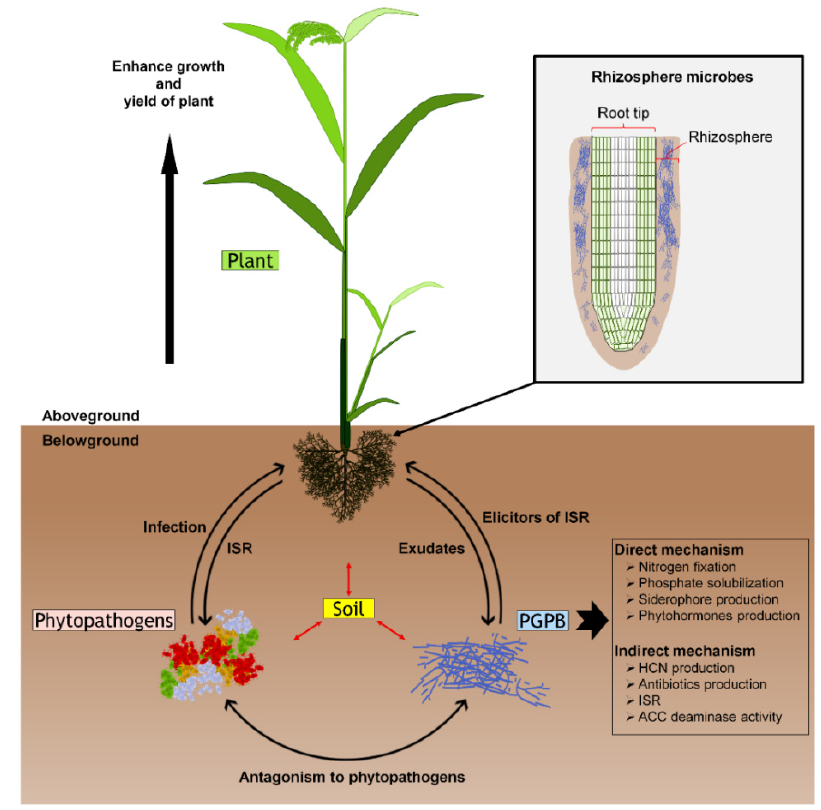
Figure 1. Biological control interactions exerted by the plant growth-promoting bacteria (PGPB). This illustration depicts the interactions between PGPB, phytopathogens, and plants. PGPB promote plant growth either by direct and or indirect mechanisms. PGPB colonize plant’s rhizosphere and produce antimicrobial metabolites. In the plant’s rhizosphere, antibiosis and nutrient competition interaction suppresses the growth of phytopathogens. Elicitors of induced systemic resistance (ISR) production by PGPB and in the simultaneous presence of phytopathogens enhanced the plant ISR. Thus, this mediated defense response of plants towards phytopathogens and consequently enhanced plant growth and health.